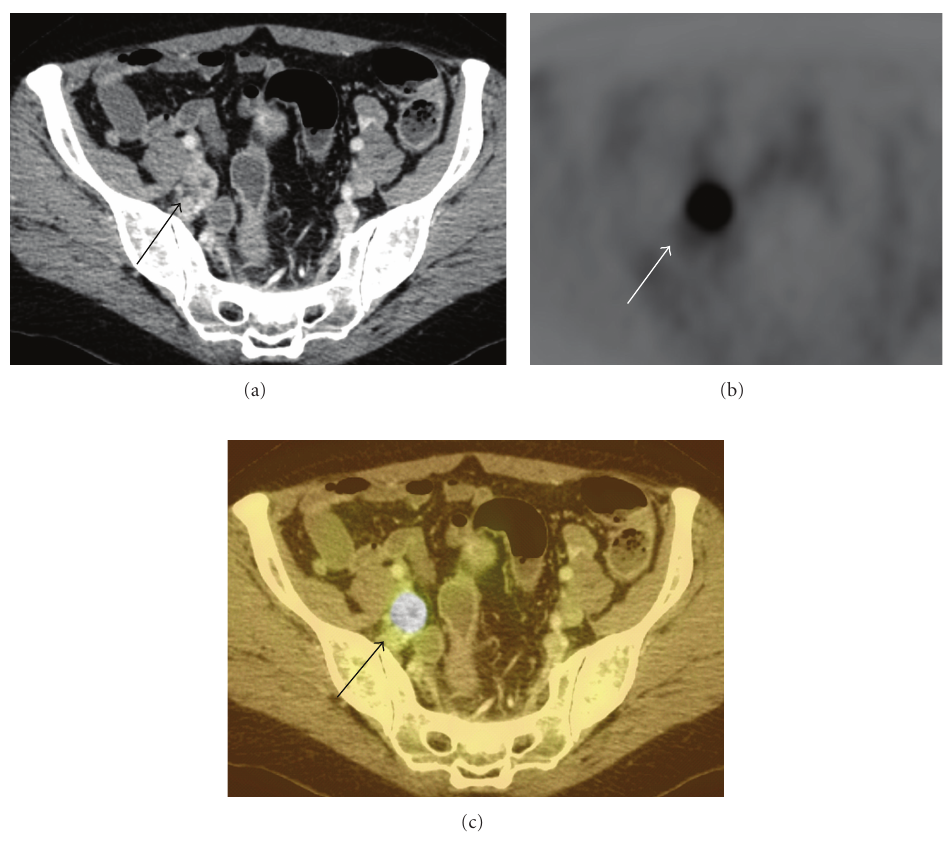
Figure 4: Rectal carcinoma with spread to the internal iliac chain lymph nodes. (a) There is an abnormally enhancing iliac lymph node (arrow) on contrast-enhanced CT. (b) There is avid radiotracer uptake (arrow) on the right side of the pelvis on FDG-PET (arrow). (c) Increased uptake on FDG-PET (arrow) correlates with the lymph node lesion seen on CT and is consistent with a malignant